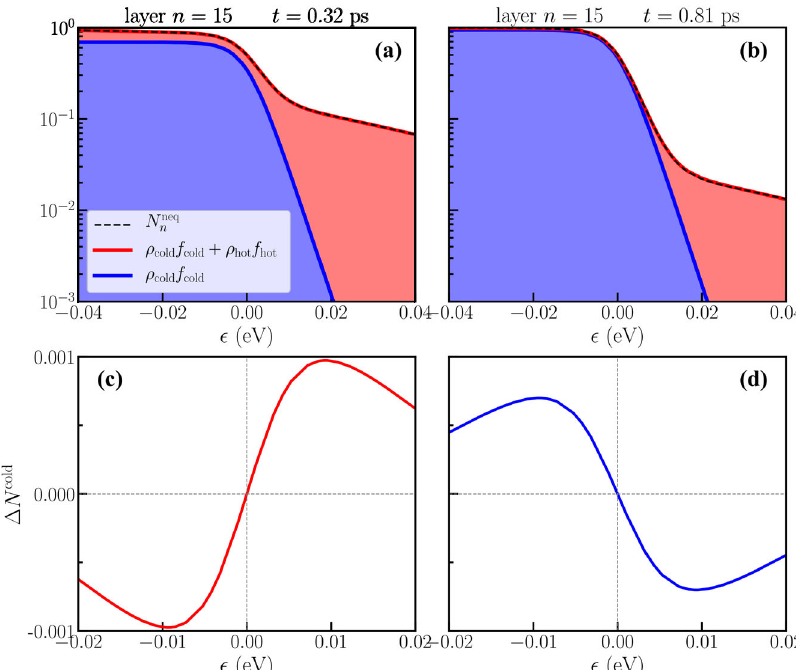
Fig. 2 Non-equilibrium distribution functions decomposition. Non-equilibrium distribution functions, Eq. (4), decomposed in terms of the cold and hot Fermi-distribution functions. Data correspond to the non-equilibrium distribution functions for the layer n = 15 at two instants of time t = 0.32 ps (left panels) and t = 0.81 ps (right panels). Top panels a, b : ρ cold f cold (blue lines) and sum of the contributions ρ cold f cold + ρ hot f hot (red line) compared with the non-equilibrium distribution functions N neq n (dashed black line), obtained by the numerical simulation. For simplicity we removed the layer and time index from the labels. The blue/red shaded regions helps to visualize the cold and hot contributions to the non-equilibrium distribution functions. Bottom panels c, d : Δ N cold , difference between the cold distribution function at the time t , and the initial one at temperature T c 0